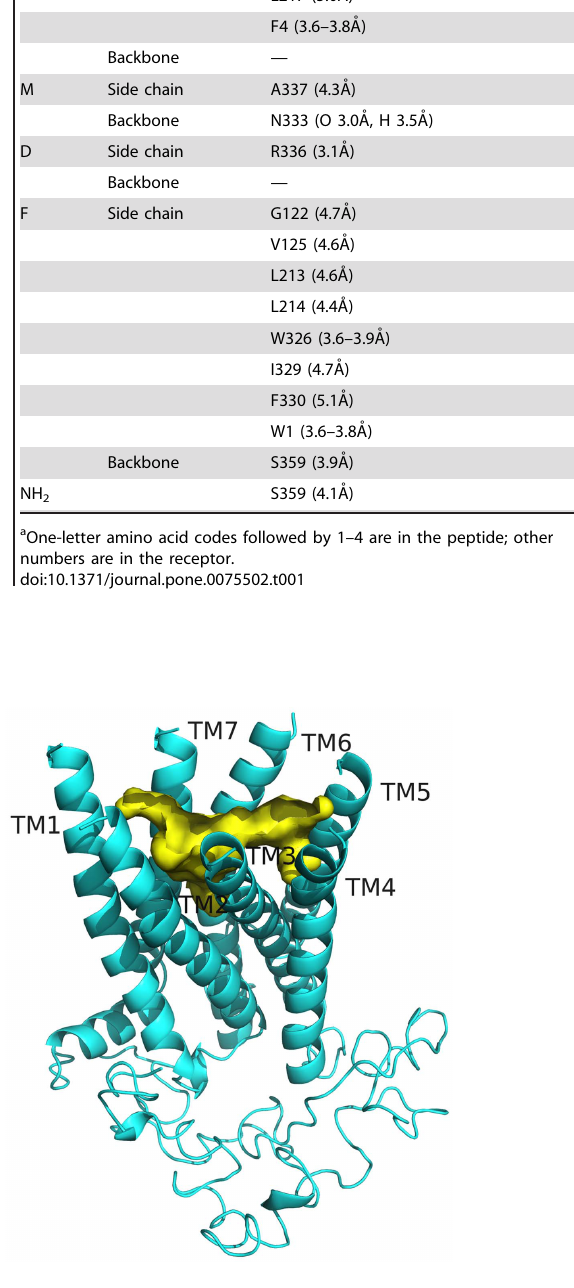
Figure 2. Model of the D.melanogaster FMRF-NH 2 receptor. The receptor (cyan) is shown as a ribbon, with ECLs removed (top), retaining the seven TM helices (middle), the ICLs and intracellular tail (bottom). The predicted ligand binding pocket (yellow) stretches across the inside of the extracellular regions of the TM helices.